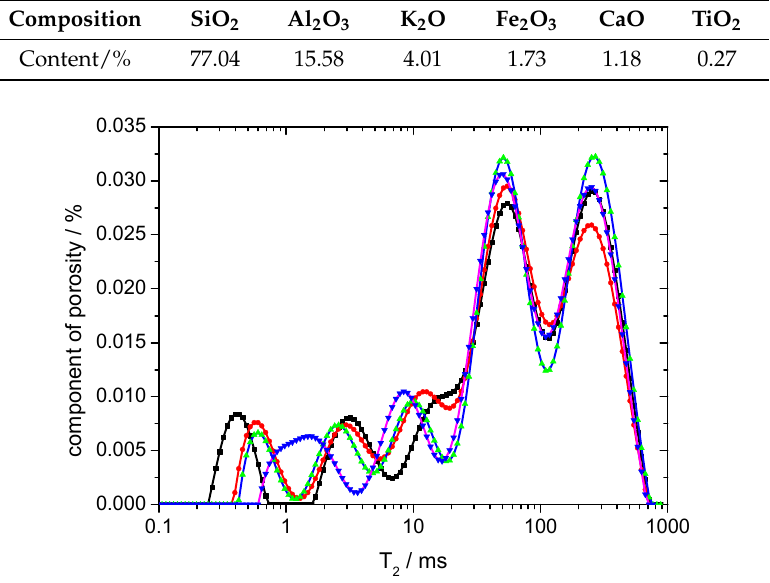
Figure 1. Curves of spectrum distributions of transverse relaxation time T 2 for the granite specimens.